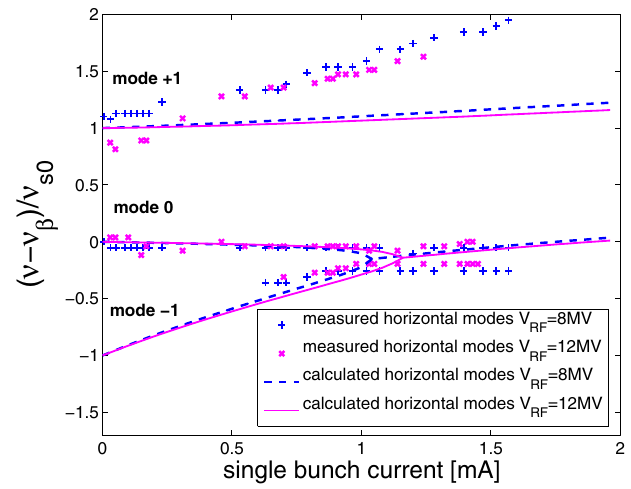
FIG. 18. (Color) Measured and calculated horizontal detuning versus single bunch current at 8 and 12 MV rf voltage. Measured thresholds around 1.3 mA. Normalization of the betatron tune shifts on the zero current synchrotron tune (cid:11) s 0